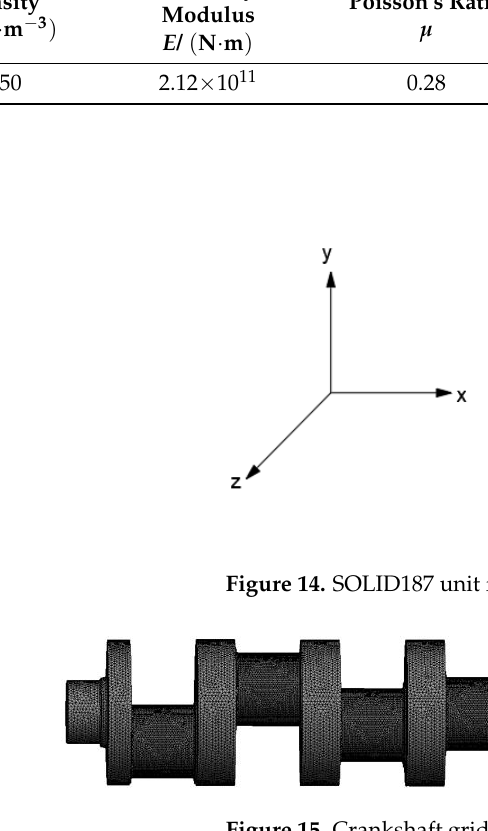
Figure 15. Crankshaft grid mode.